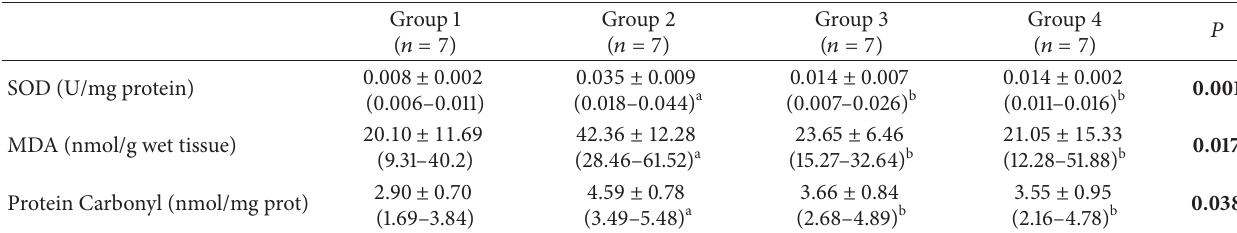
Table 2: Tissue MDA, PC levels and SOD activities.